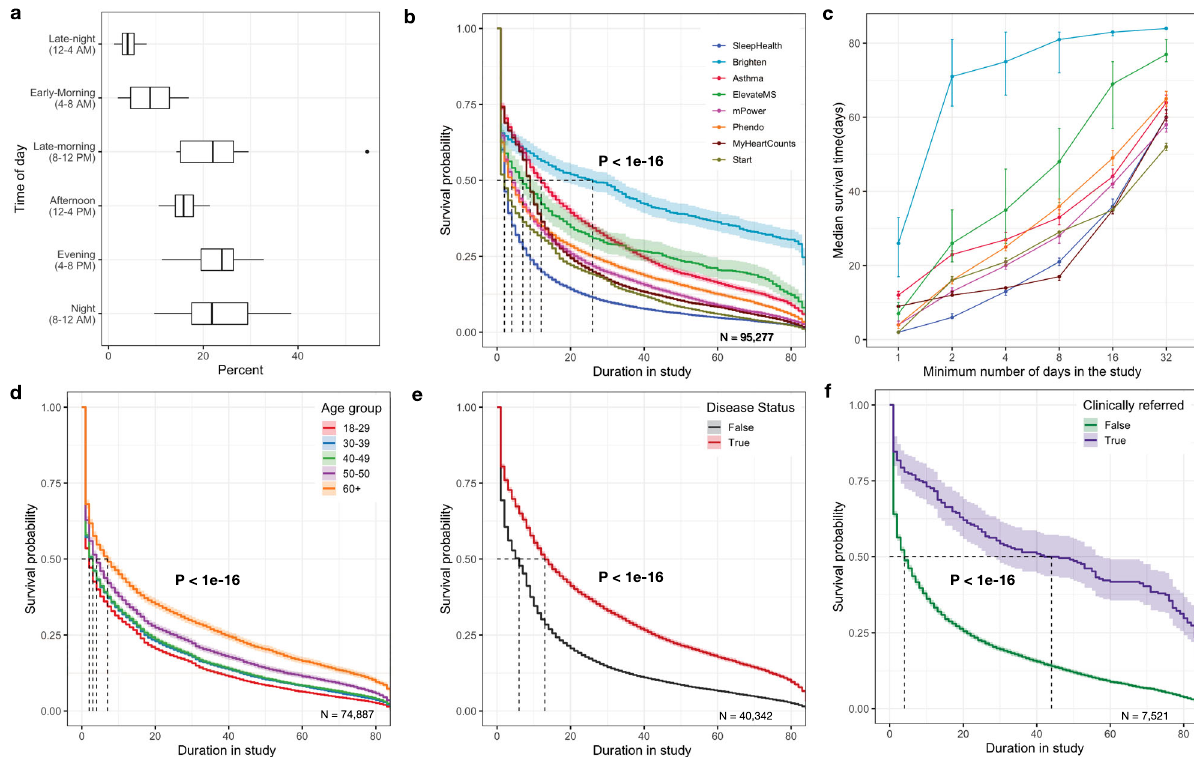
Fig. 2 Factors impacting participant retention in digital health studies. a Proportion of active tasks (N = 3.3 million) completed by participants based on their local time of day. The centerline of the boxplot shows the median value across the studies and upper and lower whisker corresponding to outlier point (1.5 times the interquartile range). b Kaplan Meir survival curve showing signi fi cant differences (P < 1e- 16) in user retention across the apps. Brighten App where monetary incentives were given to participants showed the longest retention time (Median = 26 days, 95% CI = 17 – 33) followed by Asthma(Median = 12 days, 95% CI = 11 – 13), MyHeartCounts(Median = 9 days, 95% CI = 9 – 9), ElevateMS(Median = 7 days, 95% CI = 5 – 10), mPower(Median = 5 days, 95% CI = 4 – 5), Phendo(Median = 4 days, 95% CI = 3 – 4), Start(Median = 2 days, 95% CI = 2 – 2) and SleepHealth(Median = 2 days, 95% CI = 2 – 2), c Lift curve showing the change in median survival time (with 95% CI indicated by error bars) based on the minimum number of days(1 – 32) a subset of participants continued to use the study apps, Kaplan-Meier survival curve showing signi fi cant differences in user retention across d Age group, with 60 years and older using the apps for longest duration (Median = 7days, 95% CI = 6 – 8, P < 1e-16) followed by 50 – 59 years (Median = 4 days, 95% CI = 4 – 5) and 17 – 49 years (Median = 2 – 3 days, 95% CI = 2 – 3). e Disease status; participants reporting having a disease stayed active longer(N 50 = 13days, 95% CI = 13 – 14) compared to people without disease(N 50 = 6 days, 95% CI = 5 – 6) and fi nally f Clinical referral; Two studies (mPower and ElevateMS), had a subpopulation, that were referred to the study by clinicians and showed signi fi cantly (P < 1e-16) longer app usage period(Median = 44 days, 95% CI = 27 – 58) compared to self-referred participants with disease (N 50 = 4 days, 95% CI = 4 – 4). For all survival curves the shaded region shows the 95% con fi dence limits based on the survival model fi